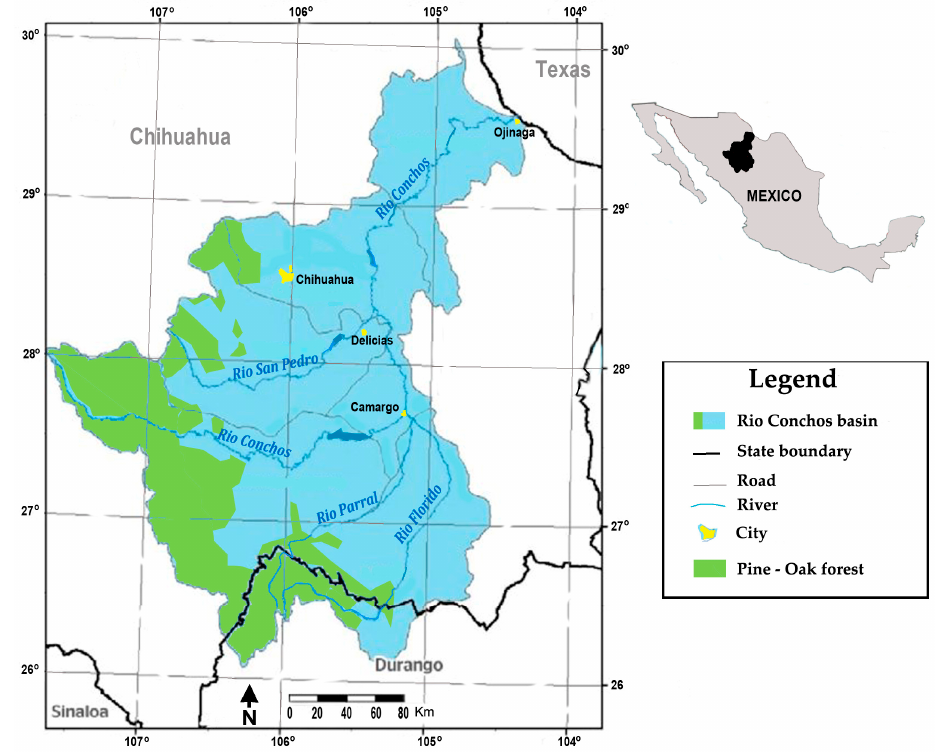
Figure 2. Rio Conchos basin and location of pine-oak forest.